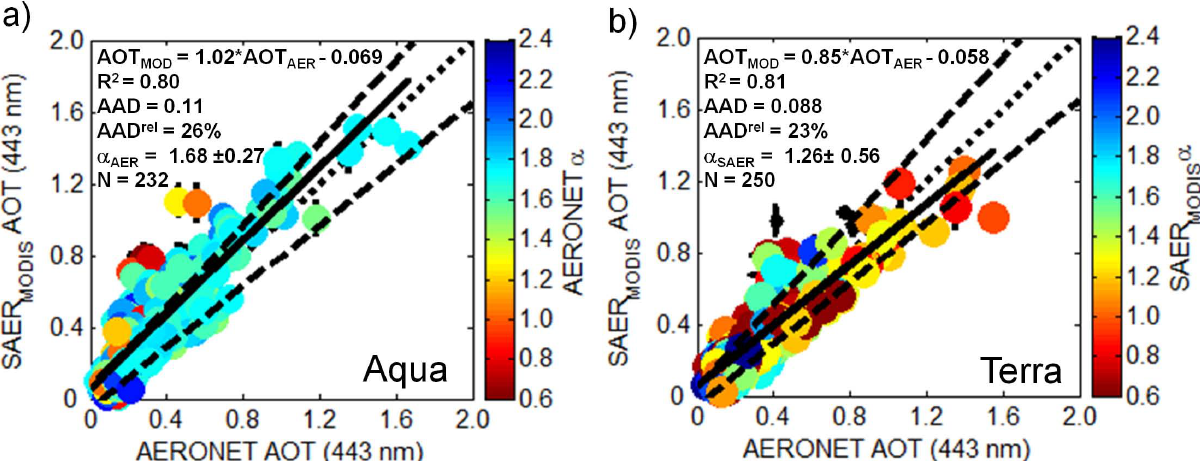
Fig. 7. Same as Fig. 4 but for a comparison of SAER MODIS and AERONET AOT at 443nm and the color coding in (b) refers to α as obtained with SAER MODIS for the wavelength pair